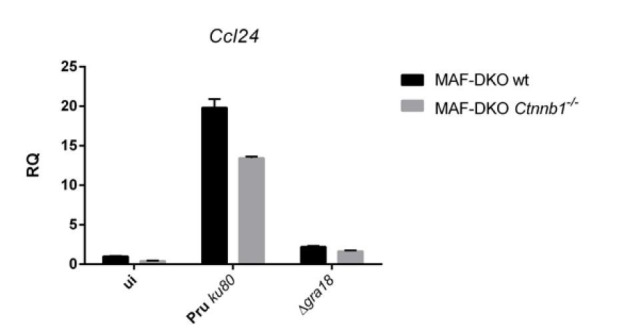
qRT-PCR analysis of MAF-DKO macrophages (high passages, after lentiviral transductions) infected by the indicated strains of T. gondii at a MOI of 1:6.